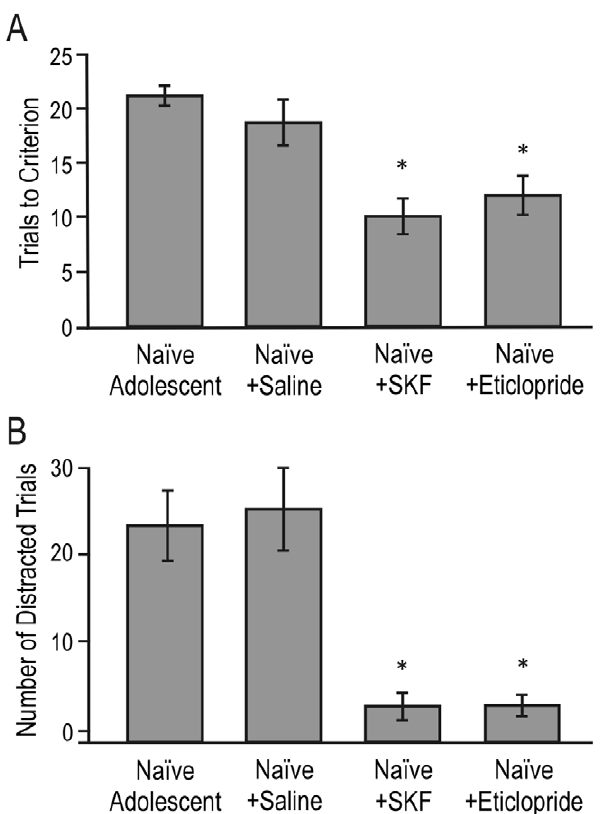
Figure 5. Drugs affecting dopamine receptors improve asso- ciative task performance and reduce distracted trials in adolescent rats. A) Average number of trials ( 6 SE) to reach criterion for naı¨ve and drug-injected adolescent animals. Both SKF and eticlopride (but not saline) reduced the number of trials required for animals to learn the odor association (* p , 0.01 compared to naı¨ve adolescents). B) Average number of trials ( 6 SE) on which adolescent rats displayed ‘‘distracted’’ behavior. Both SKF and eticlopride (but not saline) significantly decreased the number of distracted trials exhibited by adolescent rats during the odor association task compared to naı¨ve adolescents (* p , 0.05). Dunnet’s test to compare injected group means to the naı¨ve adolescent group mean.